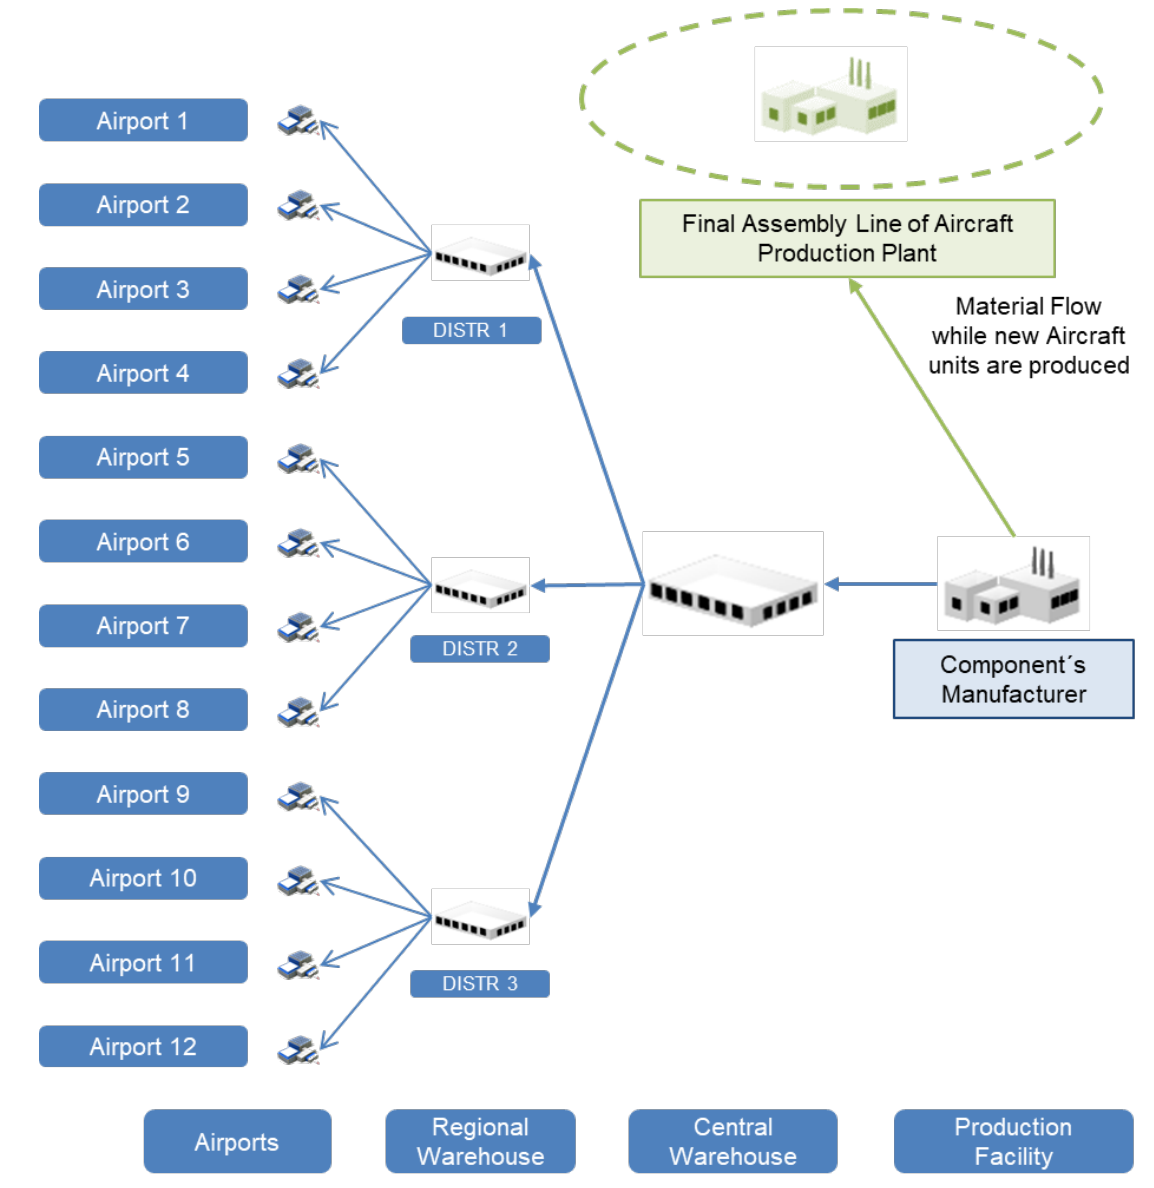
Figure 8. Distribution network sub-model (own elaboration).